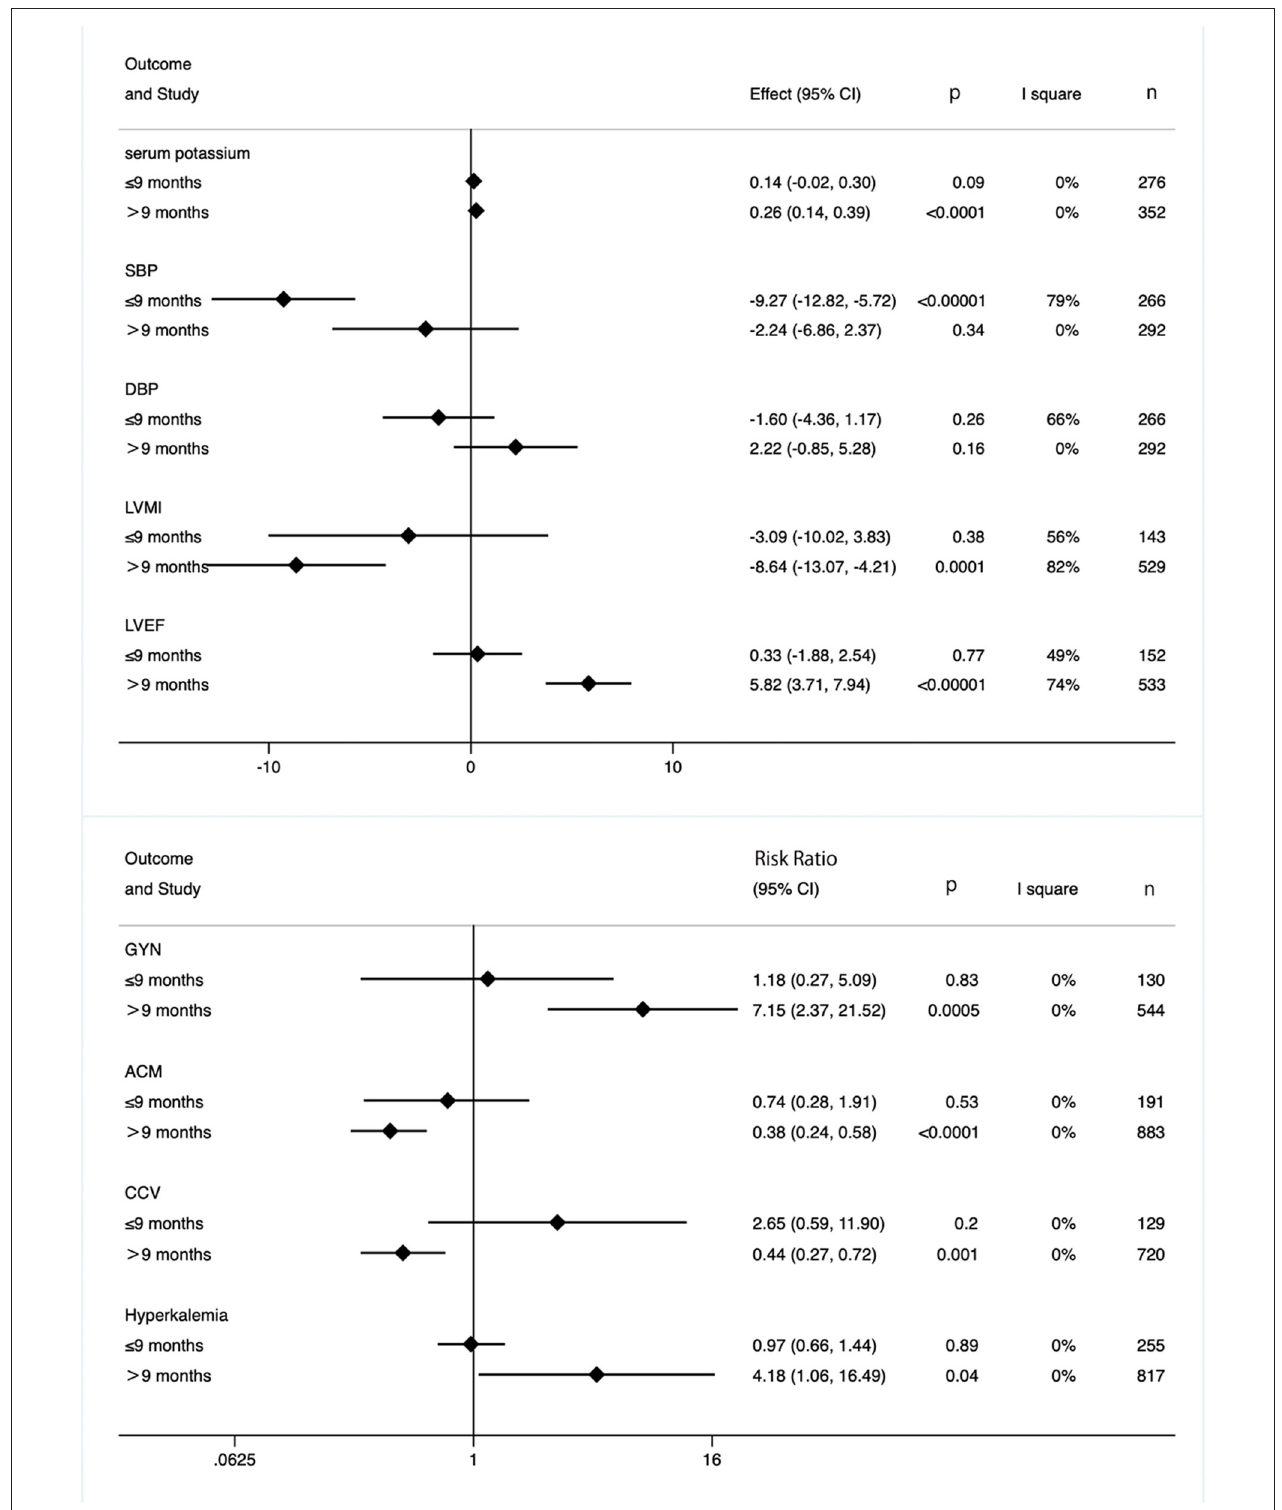
FIGURE 9 | Subgroup analysis based on